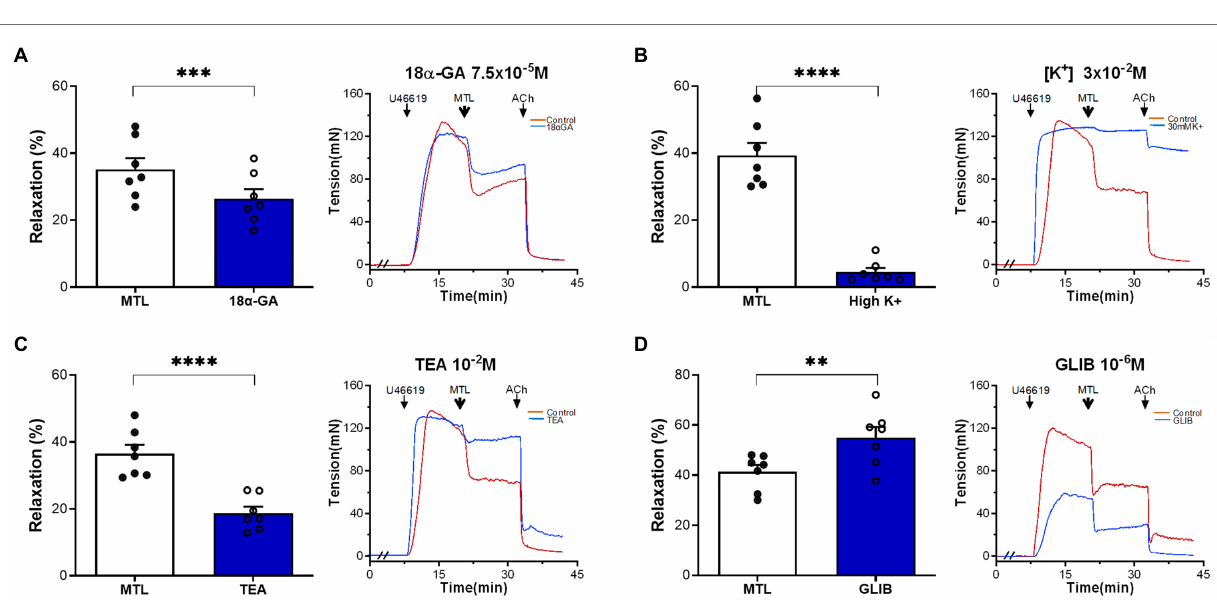
FIGURE 9 | Roles of MEGJs and K + channels on motilin-induced vasorelaxation. (A–D) Effects of 18 α -GA (7.5 × 10 − 5 M), high K + solution (3 × 10 − 2 M), TEA-Cl (10 − 2 M), and glibenclamide (10 − 6 M) on LGA relaxation induced by motilin (9 × 10 − 8 M) and corresponding representative traces. Values are means ± SEM ( n = 7). ** p < 0.01; *** p < 0.001; and **** p < 0.0001 by paired t -test. The double slash (//) indicates 18 α -GA, high K + solution, TEA-Cl, or glibenclamide pretreatment before incubation with U46619. The arrows indicate the time of drug administration. 18 α -GA, 18 α -glycyrrhetinic acid (MEGJ inhibitor); ACh, acetylcholine; GLIB, glibenclamide (K ATP channel blocker); LGA, left gastric artery; MEGJ, myoendothelial gap junction; MTL, motilin; SEM, standard error of the mean; TEA-Cl, tetraethylammonium chloride (K Ca channel blocker); and U46619, thromboxane A 2 receptor agonist.